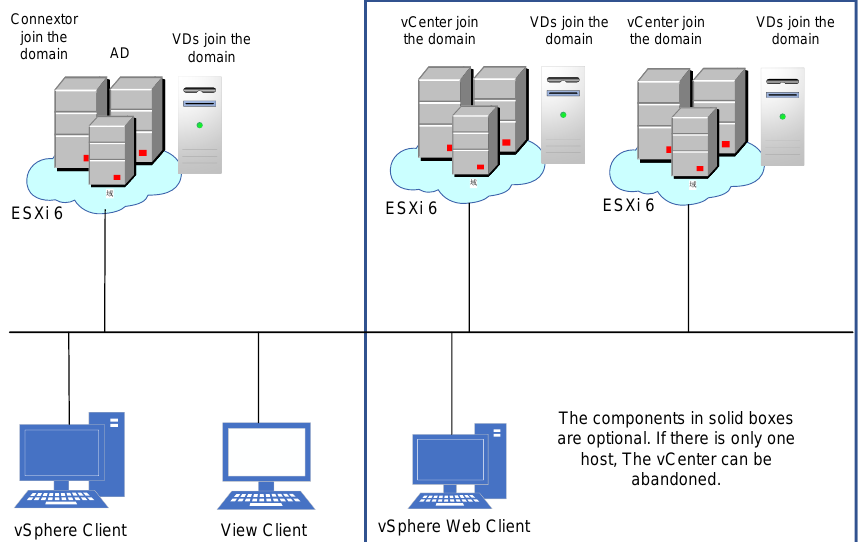
Figure 1. Schematic diagram of the smallest cloud computing